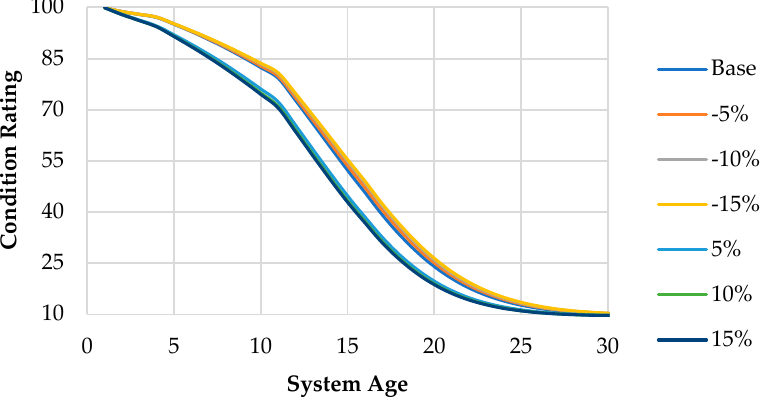
Figure 5. Output alteration upon condition parameter incrementation.